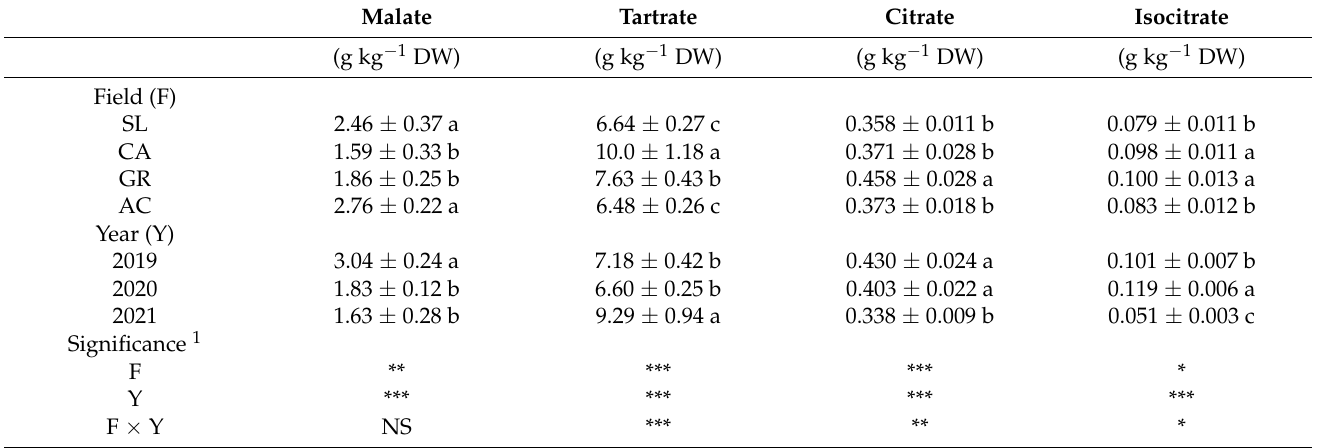
Table 3. Effects of field (F), year (Y), and their interaction (F × Y) on must organic acids content in V. vinifera subsp. vinifera “Falanghina” vines at the four study sites: SL-Santa Lucia, CA-Calvese, GR-Grottole, AC-Acquafredde. Mean values and standard errors are shown. Different letters within each column indicate significant differences according to Duncan’s multiple-range test ( p ≤ 0.05). Malate Tartrate Citrate